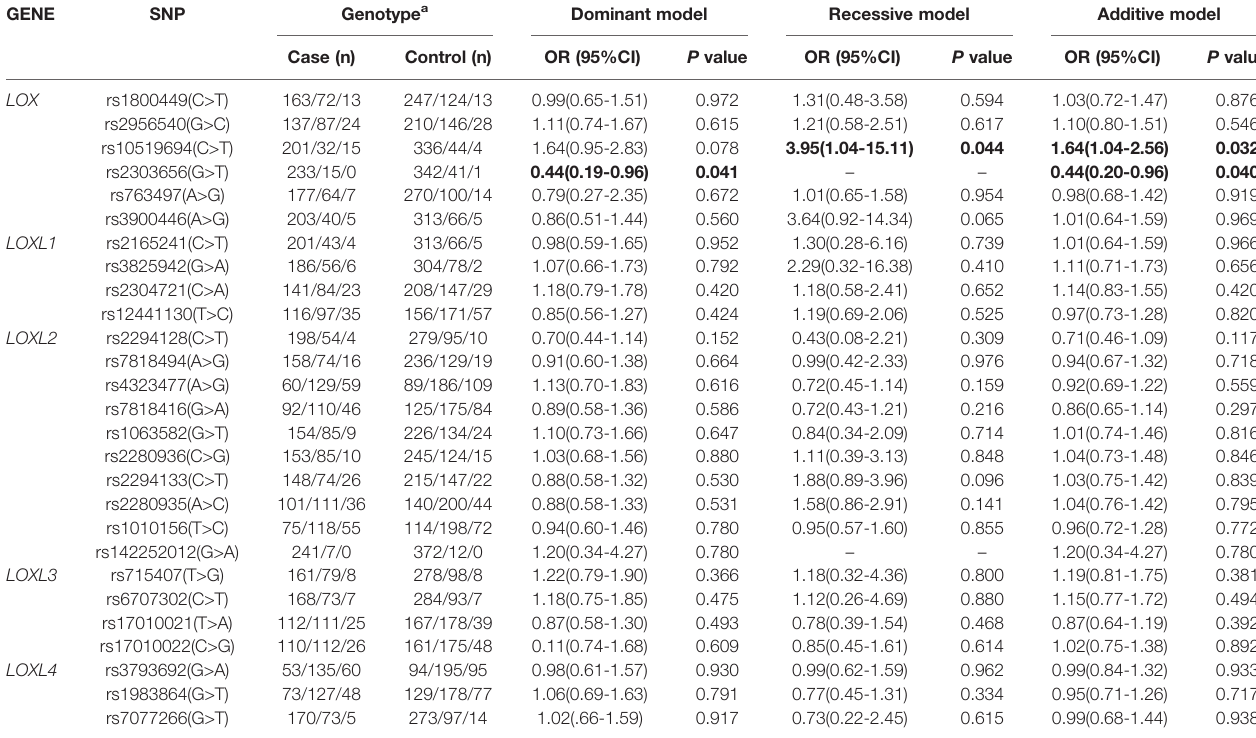
TABLE 4 | Multivariate logistic regression analysis of associations of polymorphisms in LOX family genes and risk of single IA in a Chinese population. GENE